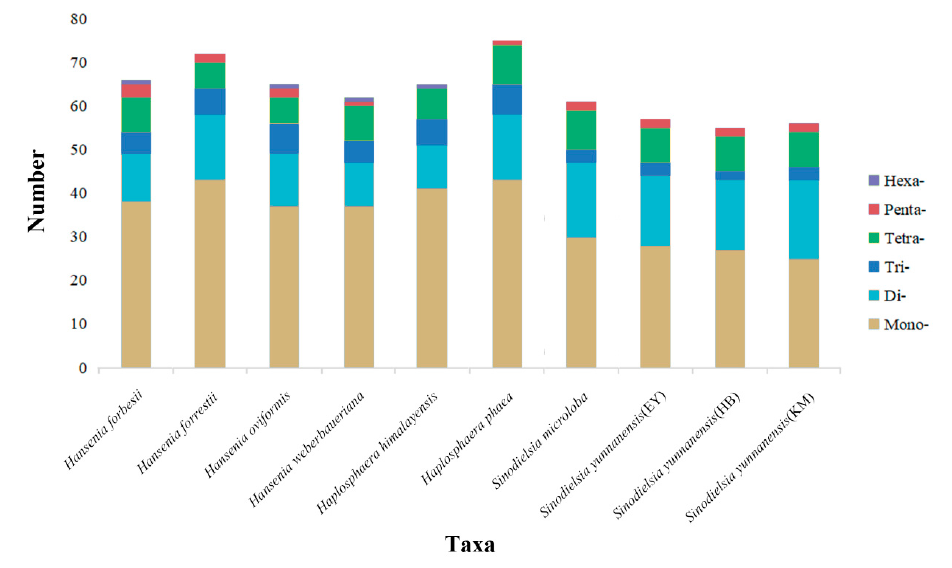
Figure 5. Frequency of detected simple sequence repeat (SSR) motifs in different repeat types in ten Hansenia , Haplosphaera and Sinodielsia plastid genomes.